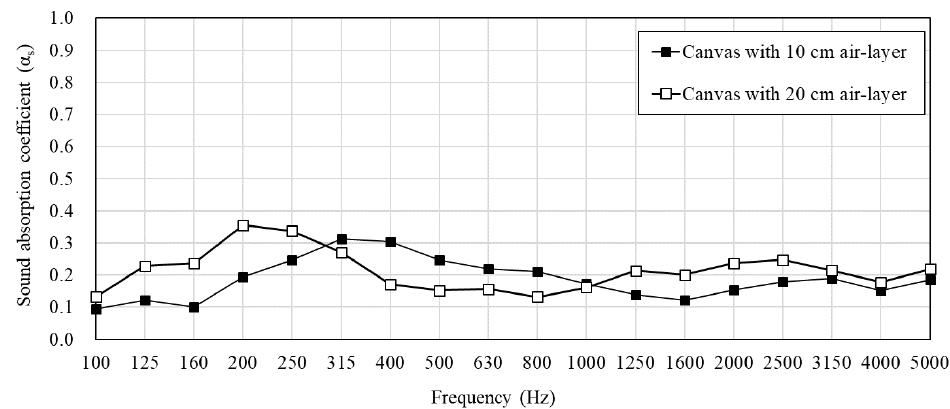
Figure 8. The sound absorption coefficient of canvas with single-layer structure in stage 1.